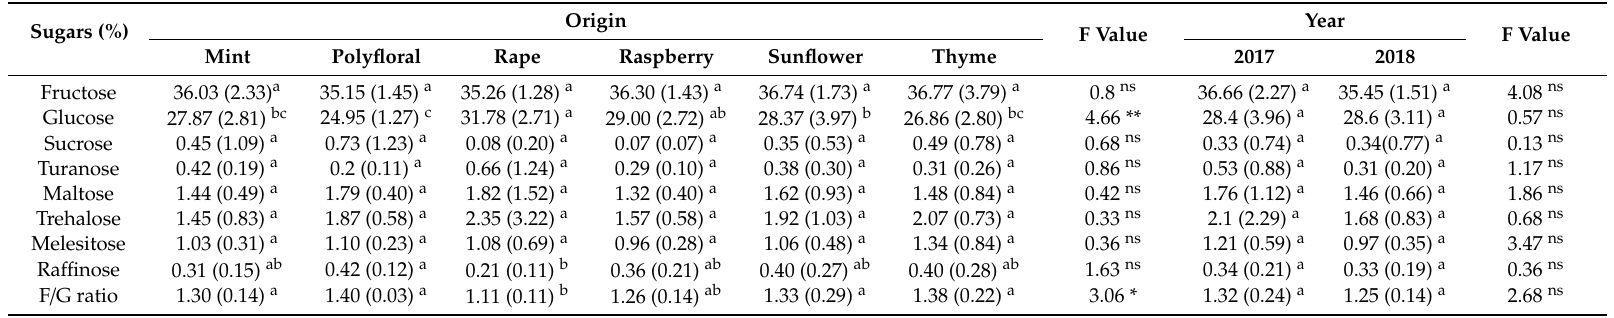
Table 3. Sugars content for di ff erent types of Romanian honey. Mean values and standard deviation in brackets.